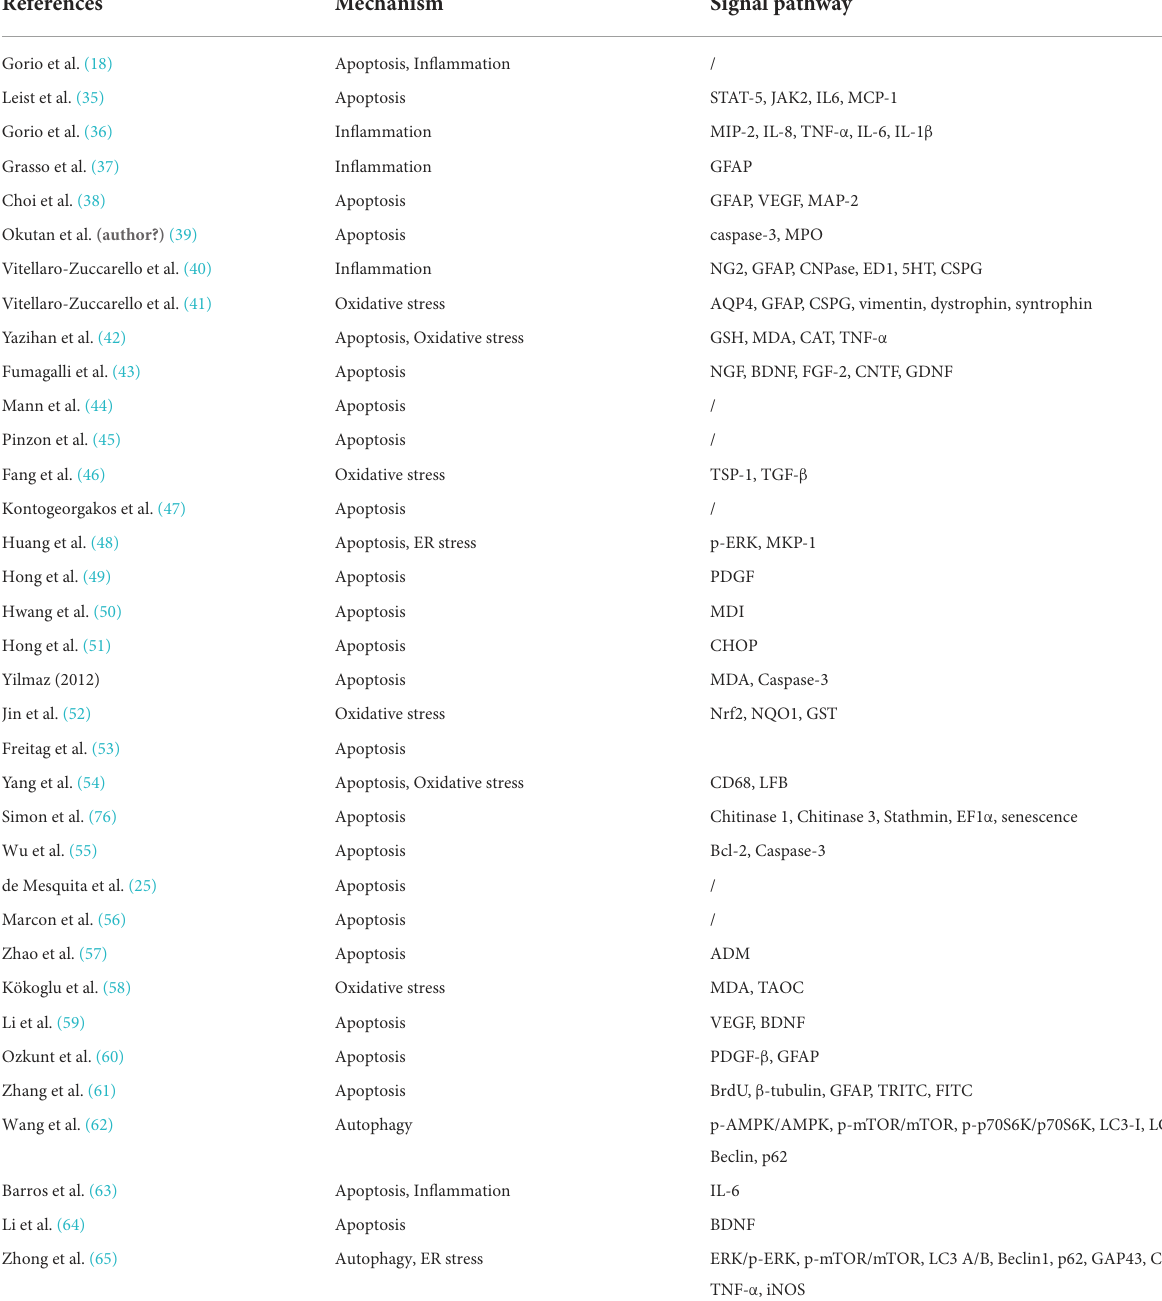
TABLE 4 The signal pathway of EPO for